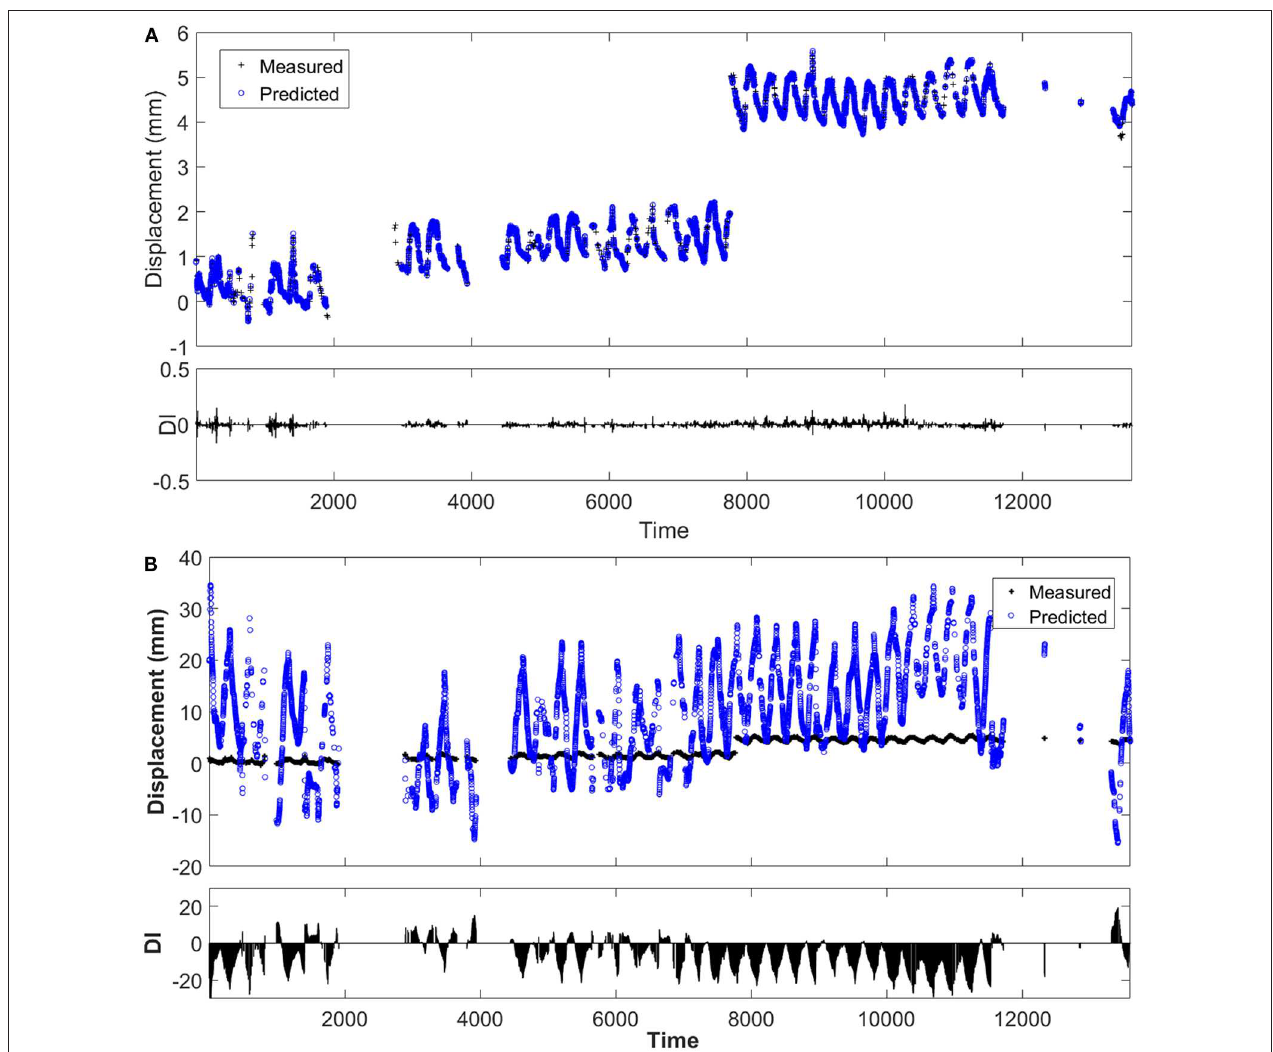
FIGURE 14 | (A) Pier C measured and ANN predicted results and (B) Pier C measured and conventional SHM baseline